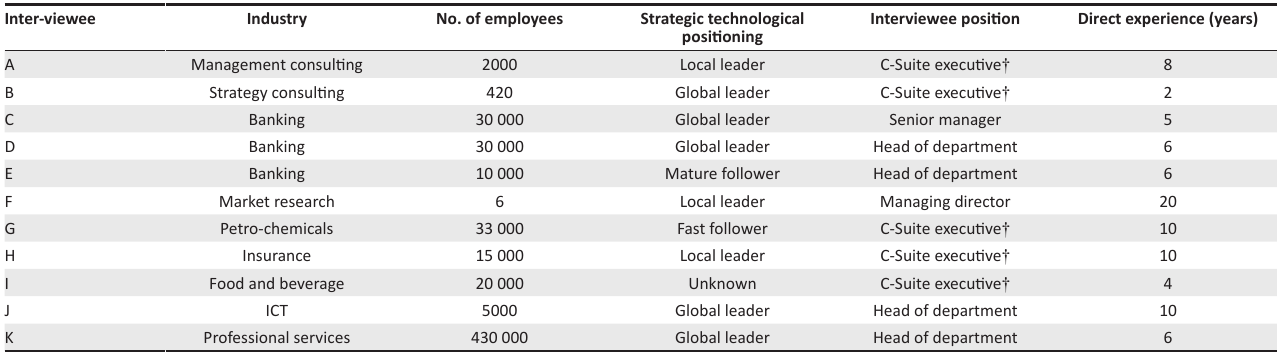
TABLE 3: Attributes of interviewees.